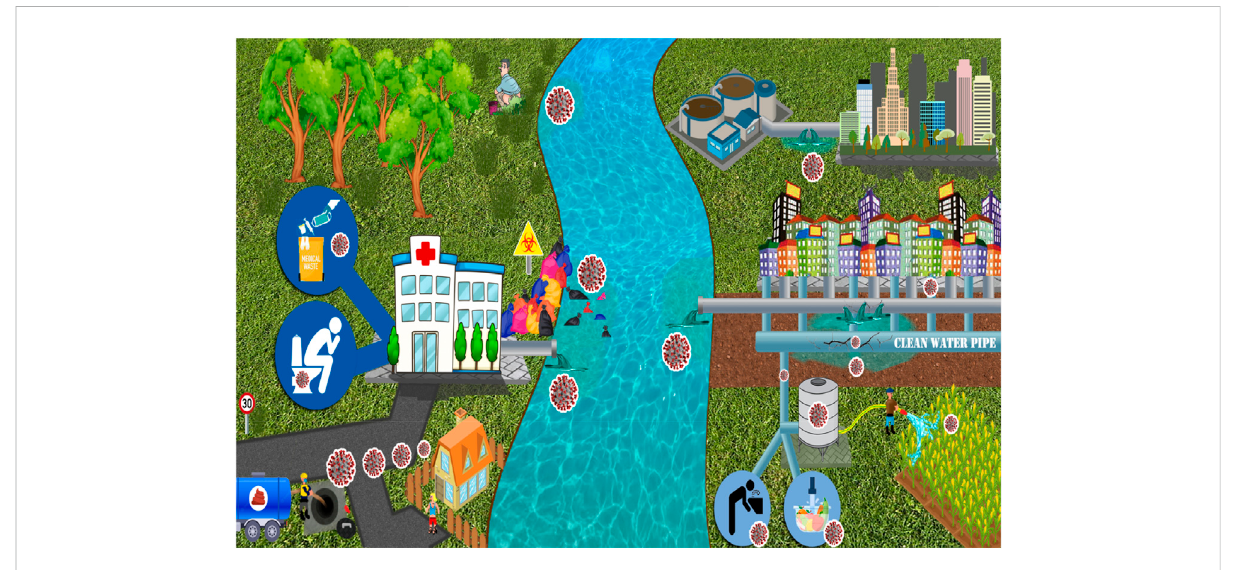
FIGURE 1 Probable routes of transmission of SARS-CoV-2 through wastewater.